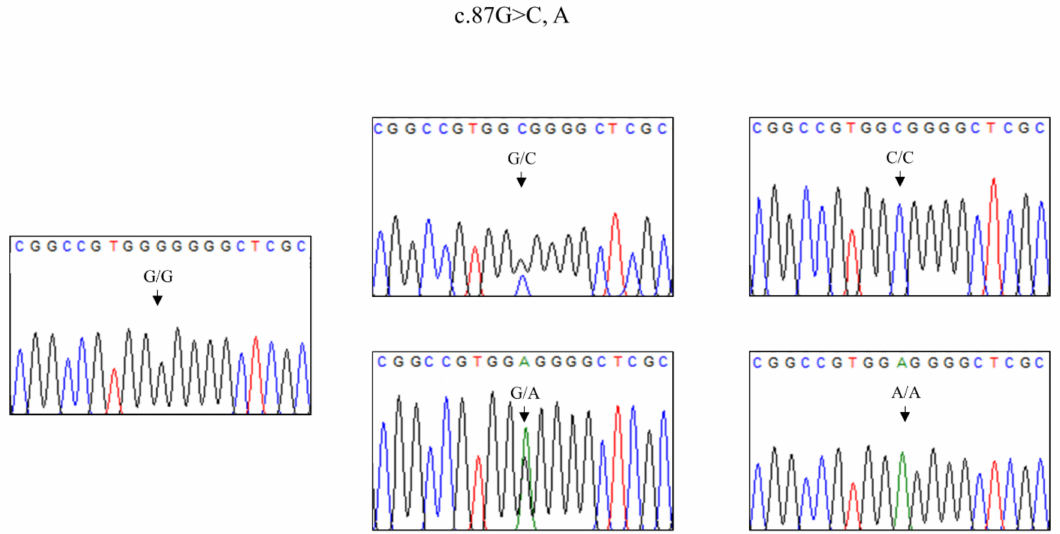
Figure 1. Novel polymorphism of the shadow of the prion protein gene ( SPRN ) identified in Jeju and Halla horses.The electropherogram represents a novel polymorphism, c.87G > A, found in this study. The black arrows indicate the position of SNP. The four DNA nucleotides are represented by different colors: cytosine (blue), thymine (red), guanine (black), and adenine (green). Table 1. Allele frequencies of shadow of prion protein gene ( SPRN ) SNPs in Jeju, Halla and Thoroughbred horses. Polymorphisms